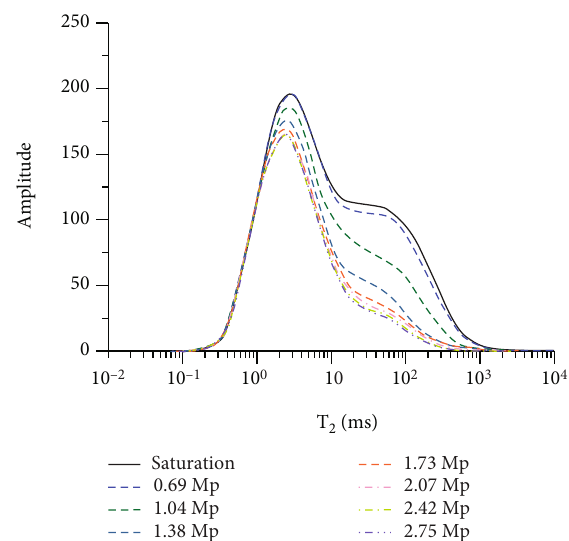
Figure 12: T 2 spectrogram curve in various pressures for tight sandstones in study